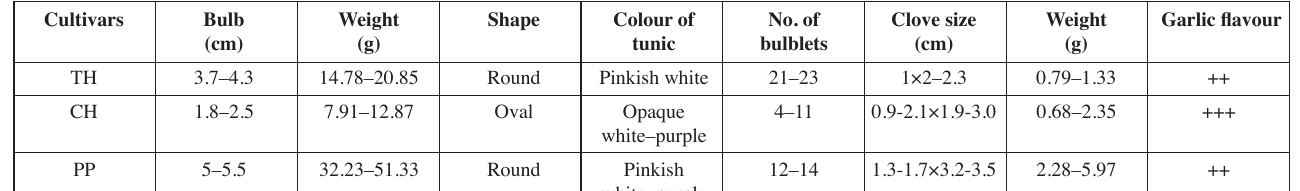
Tab. 2: The morphological descriptions of three garlic cultivars